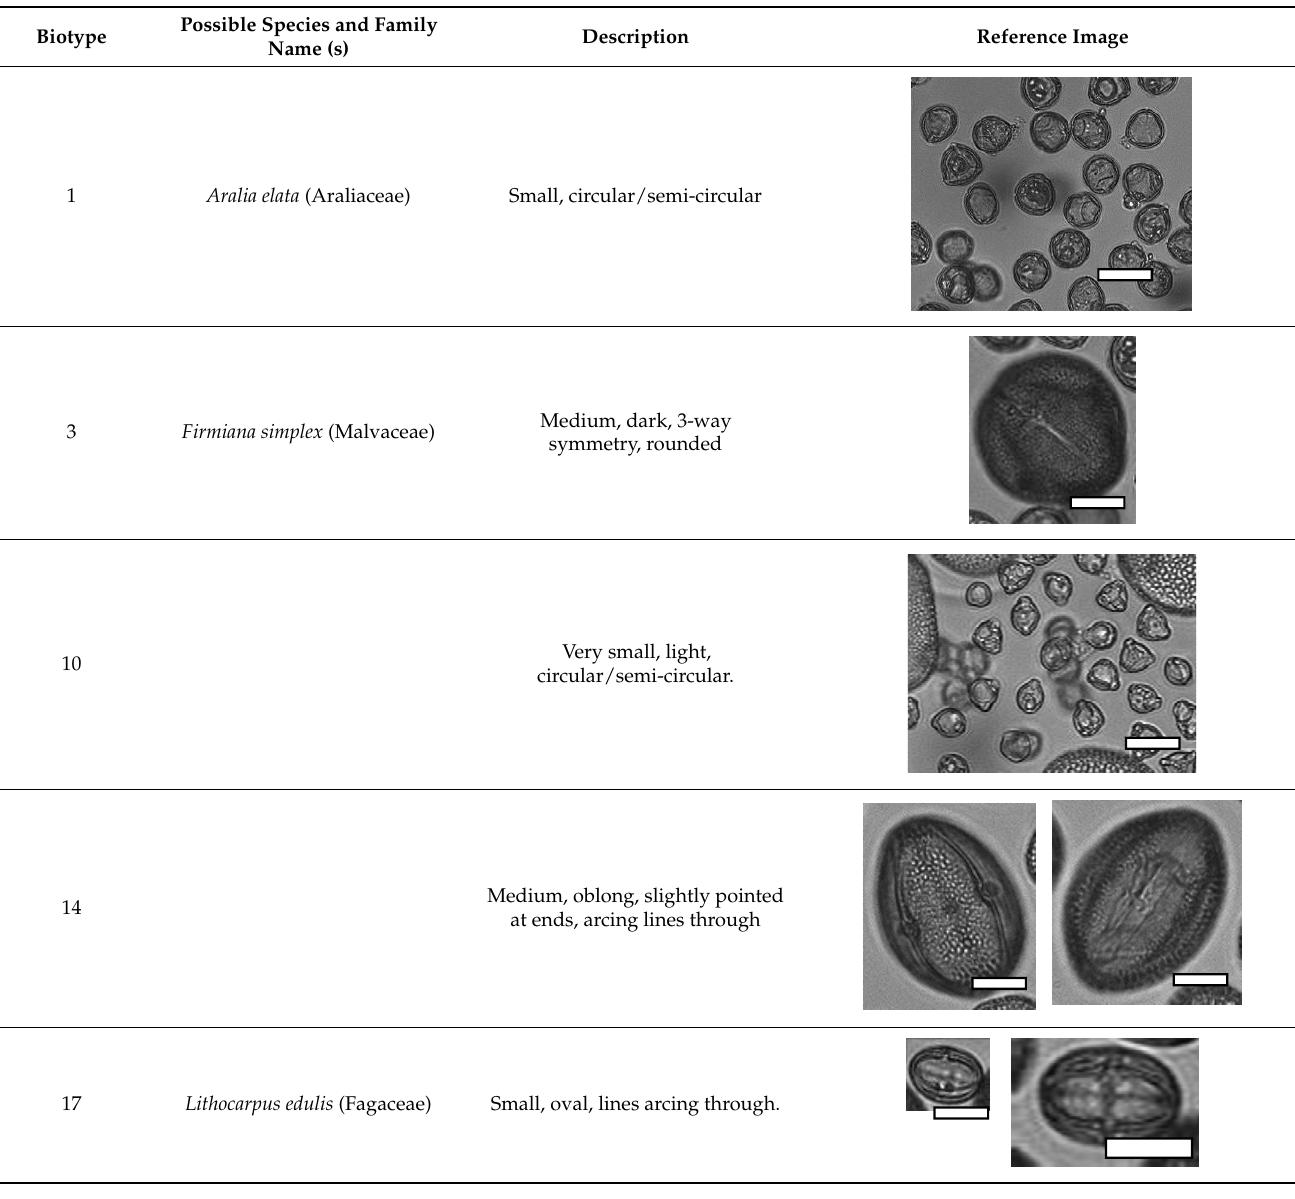
Table 1. Dominant biotype classifications and descriptions used to identify pollen grains found in samples collected from five Apis cerana japonica hives in Japan, between June and September 2019. Potential family and species names are also given where possible, based on pollen samples collected directly from flowering plants and identified using a palynomorph guide of Japanese flora by Shimakura [53]. Reference images are approximately relatively sized, as indicated by scale bar (50 µ m).